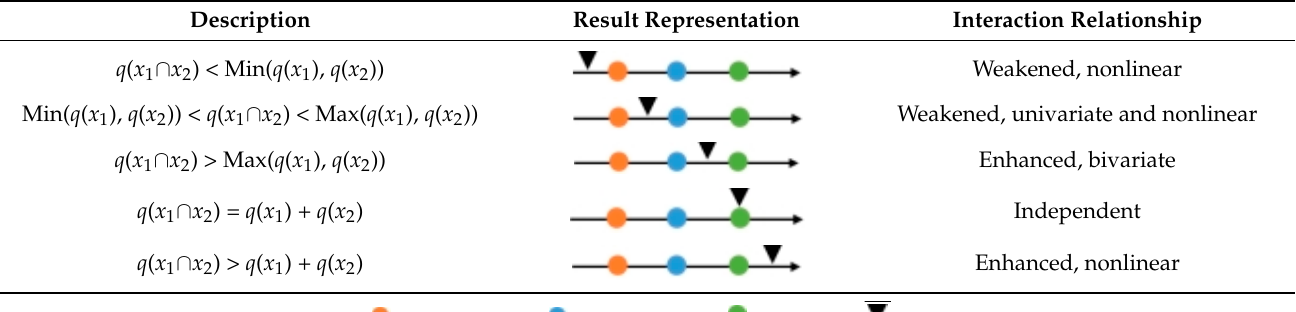
Table 3. Descriptions and interaction relationships.